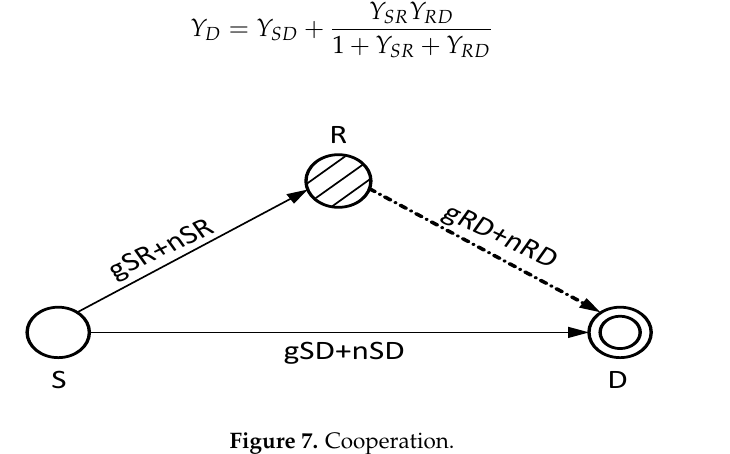
Figure 7. Cooperation.